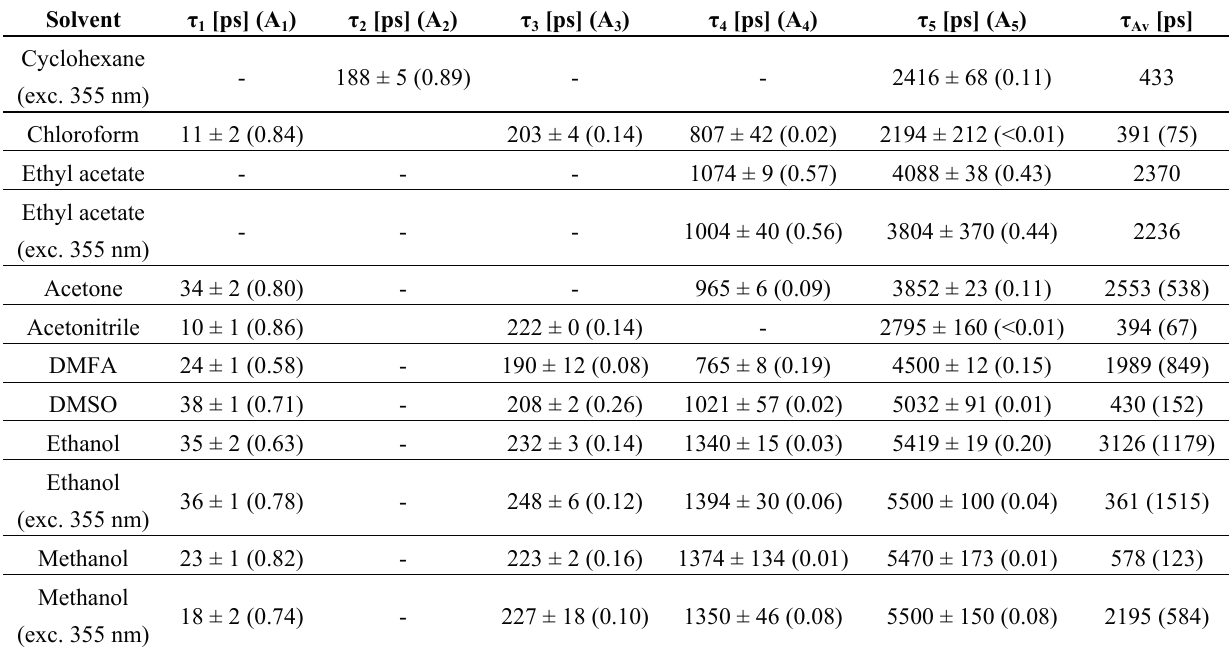
Table 4. Decay parameters of CYV in selected